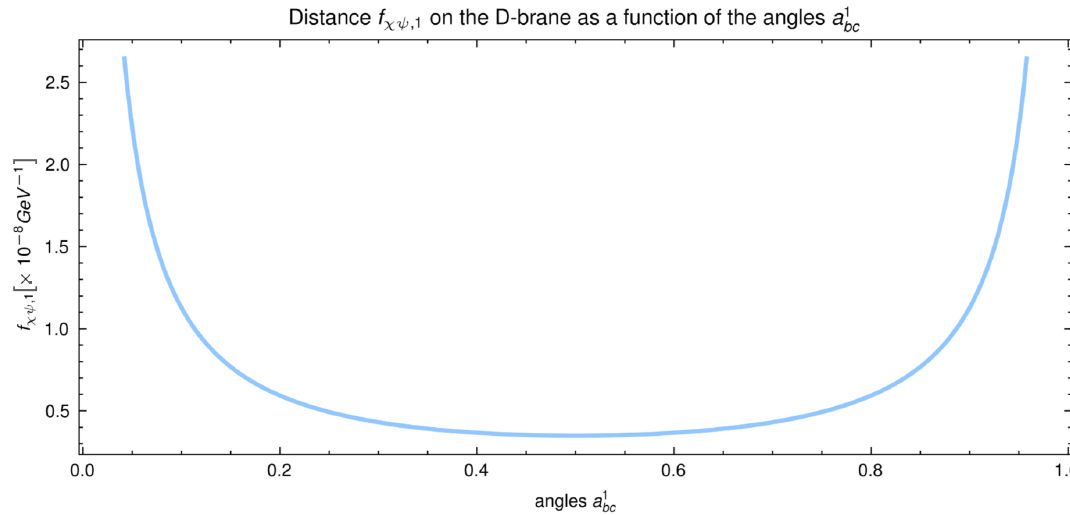
Figure 7 . Length f χψ, 1 in terms of the angle a 1 M s = 10 TeV , so that the excited Higgs ˜ h has a mass m ˜ 2 . 5 10 − 10 to the ( g ×